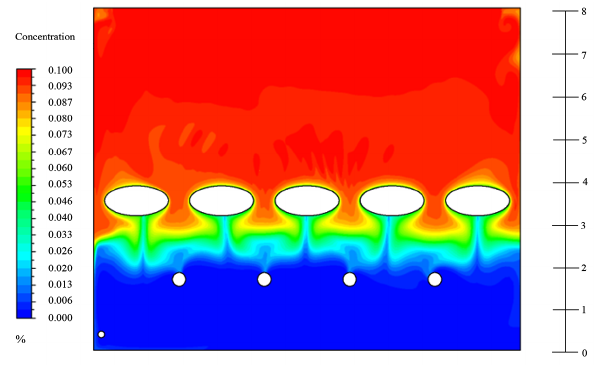
Figure 7. The diagram of distribution of the СО 2 concentration within the capacity of winter